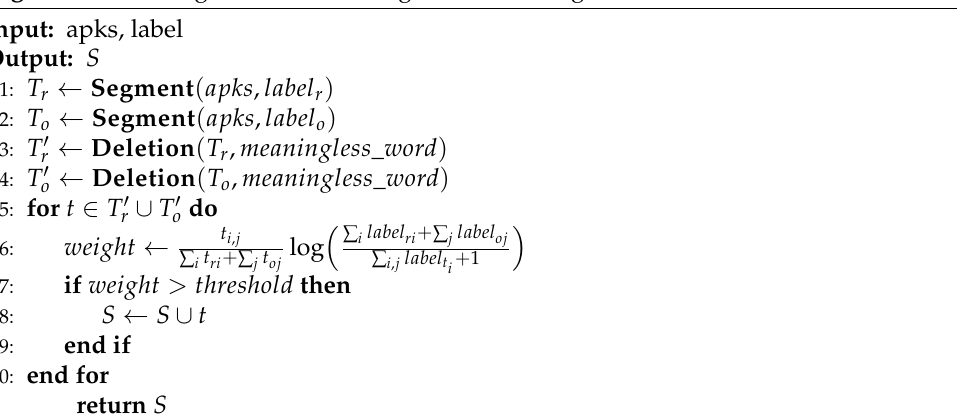
Algorithm 1 The algorithm of building sensitive strings set